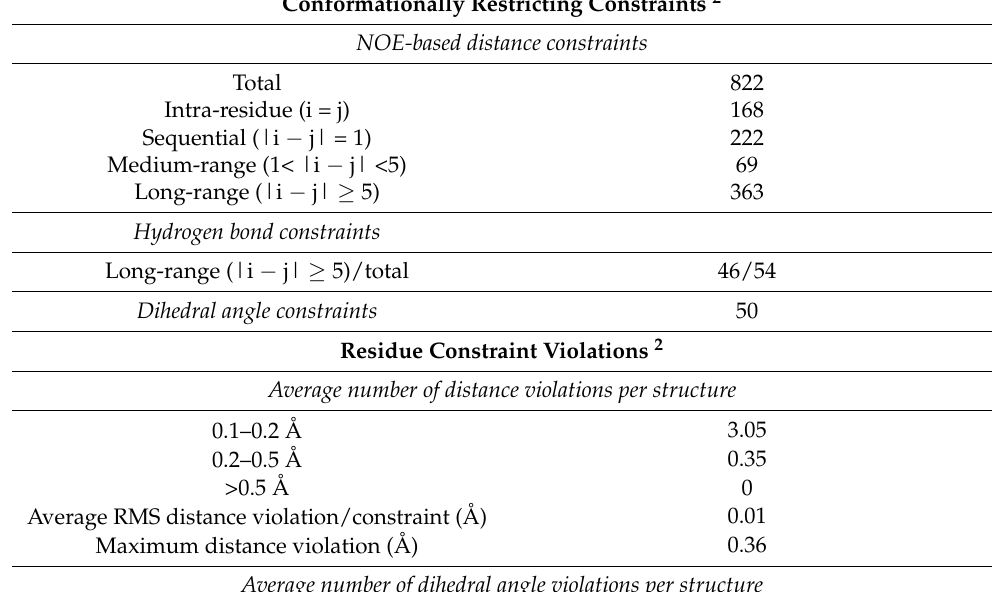
Table 1. Structural statistics for CpAcp SH3b6 1